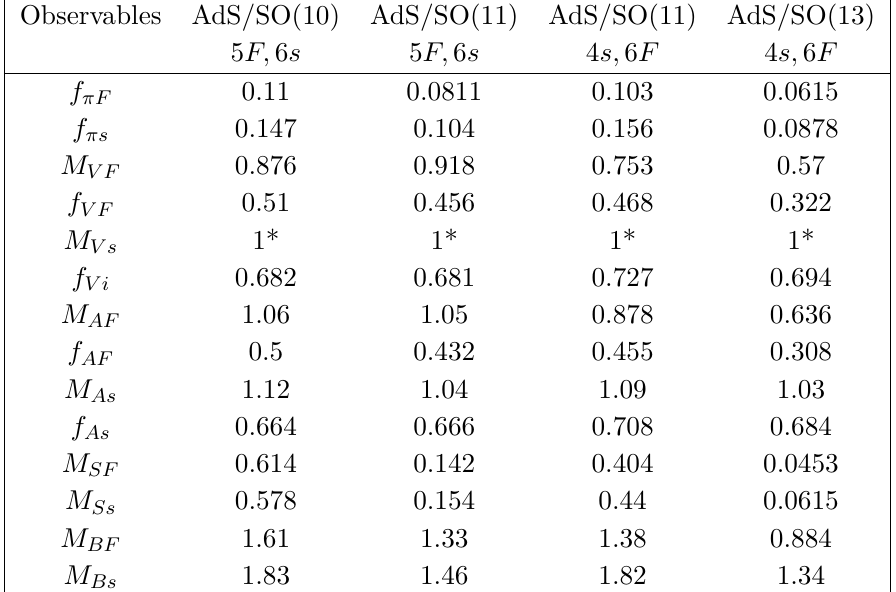
Table 9. Holographic results for the masses and decay constants for the two SO(10) , the SO(11) and the SO(13) theories with two matter representations that can trigger chiral symmetry